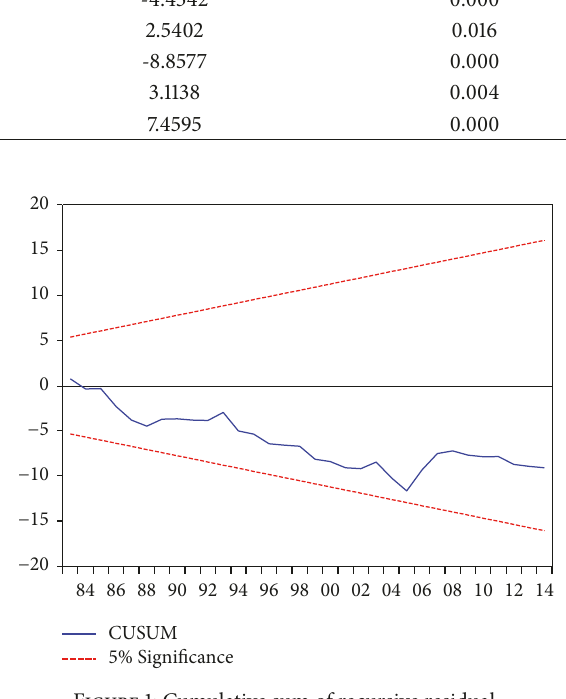
Figure 1: Cumulative sum of recursive